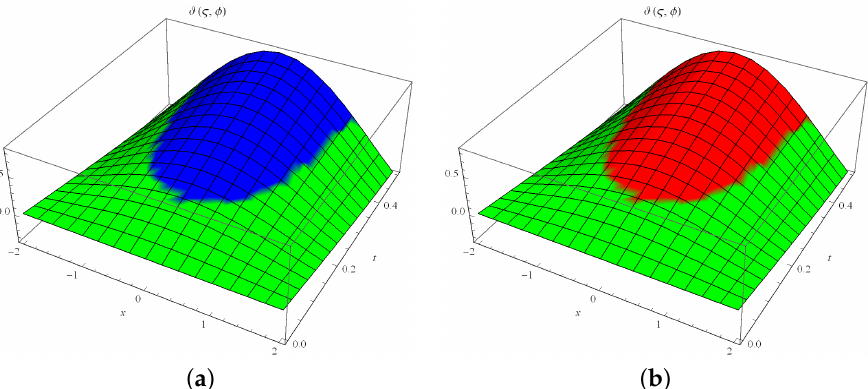
Figure 1. Surface solutions of 1D wave equation. ( a ) Surface plot for approximate results. ( b ) Surface plot for precise results.